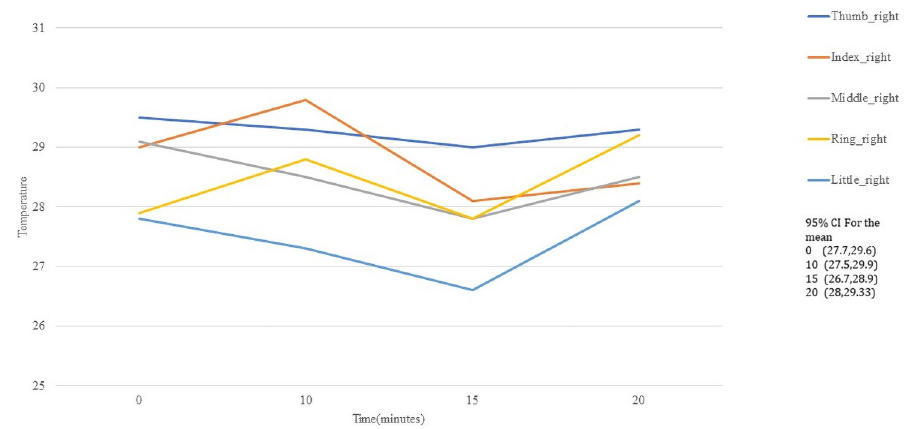
Fig 5. Temperature behaviour of the fingers in dorsal right hand.